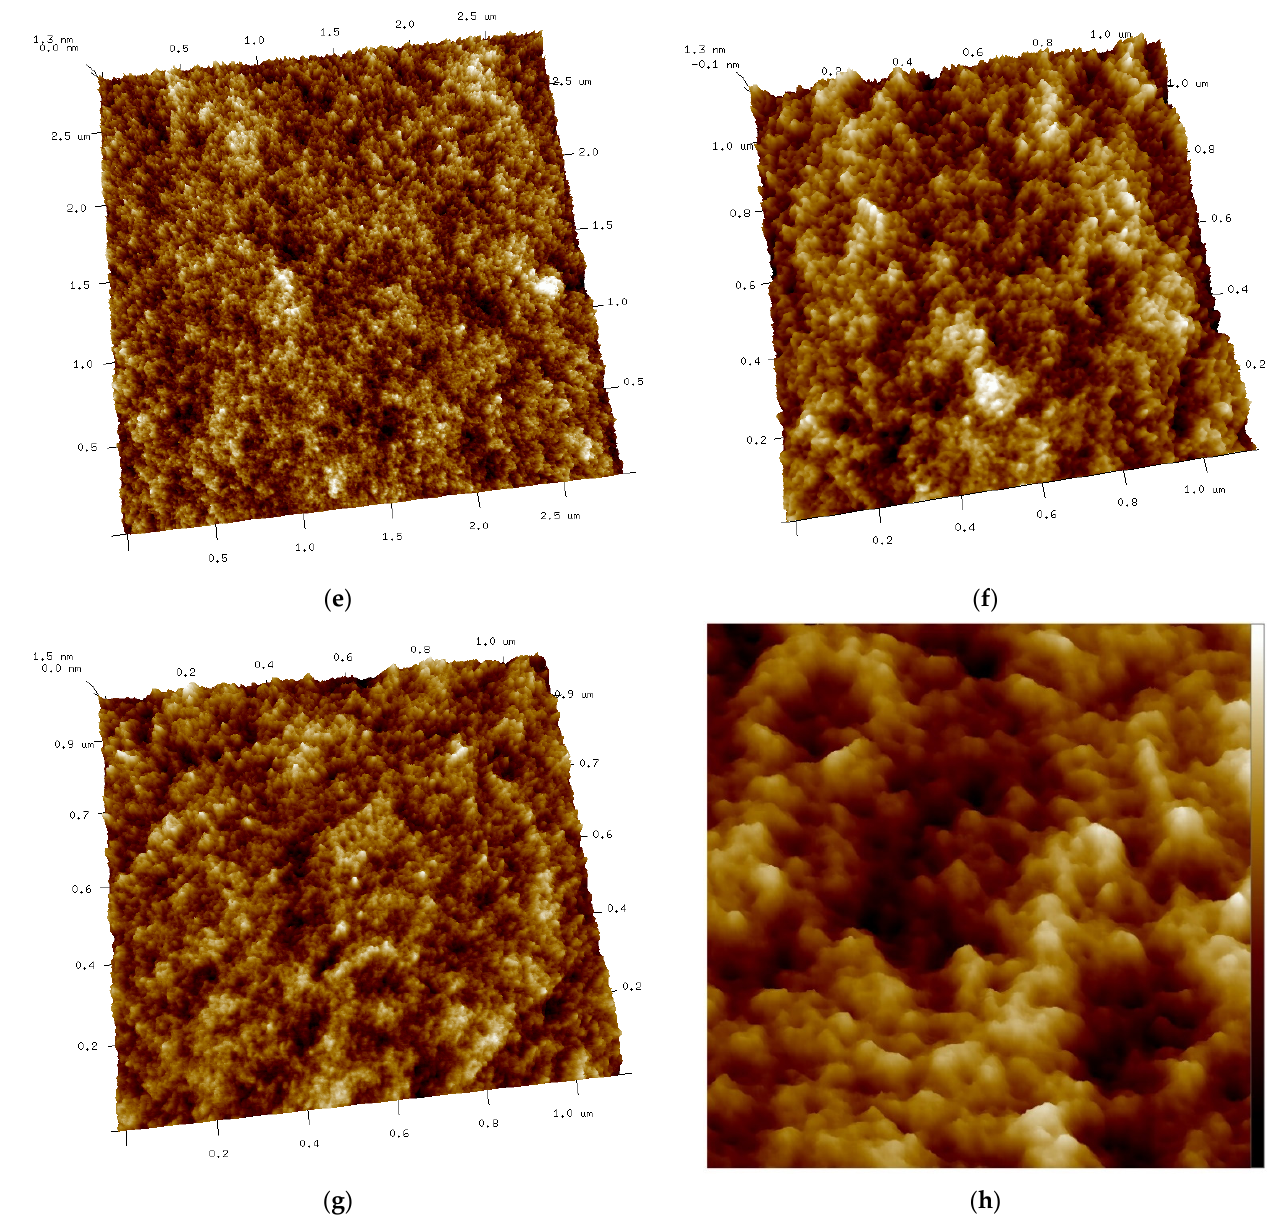
Figure 8. ( a – d ) AFM 2D images of Tuna gelatin hydrogel. ( a ) Zone 1 at a magnification of 2.8 × 2.8 µm 2 , ( b ) Zone 2 at a magnification of 3.3 × 3.3 µm 2 , ( c ) Zone 3 at a magnification of 3.3 × 3.3 µm 2 , ( d ) Zone 3 at a magnification of 1.1 × 1.1 µm 2 . ( e – g ) AFM 3D images of Tuna gelatin hydrogel. ( e ) Zone 1 at 1.2 nm, ( f ) Zone 2 at 1.3 nm, ( g ) Zone 3 at 1.5 nm. ( h ) Zoom images 3D in zone 1 with magnifications 120–120 nm 2 .